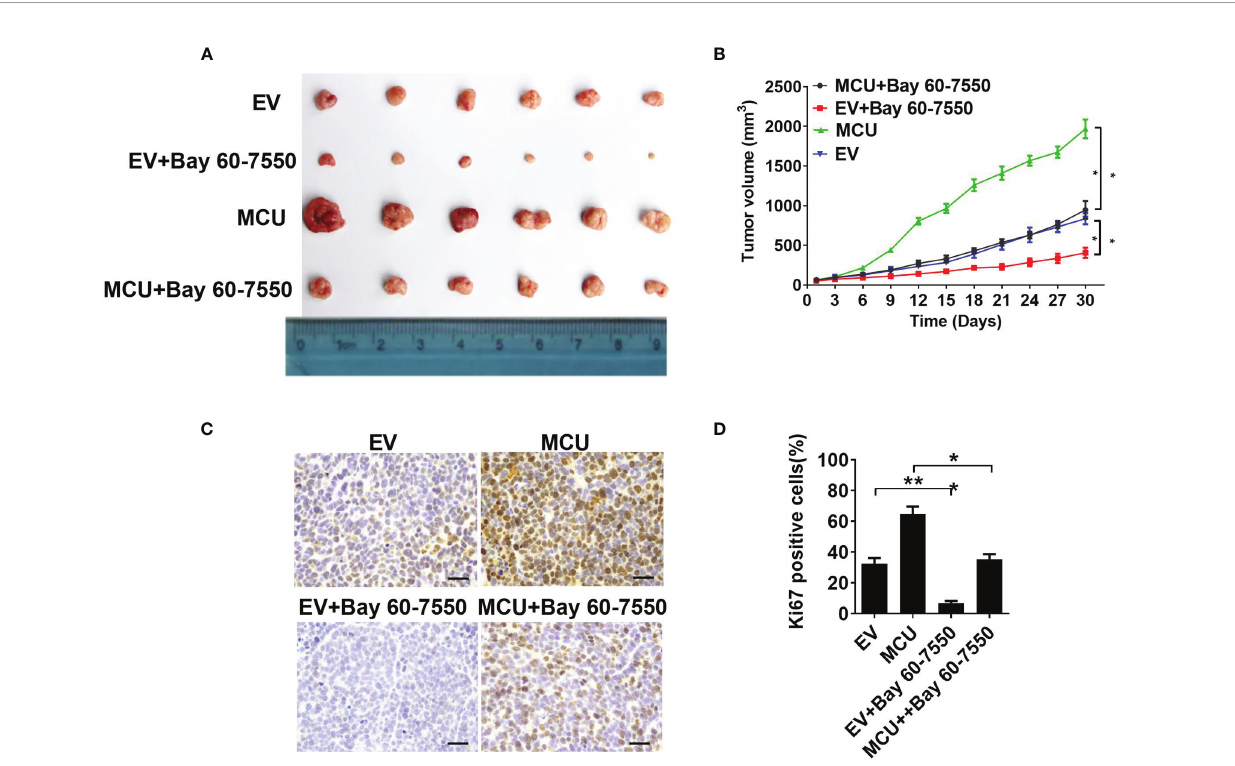
FIGURE 4 | Activation of PDE2 is essential for mitochondrial Ca2+-mediated CRC cell proliferation in vivo . (A) Dissected tumors from sacri fi ced mice and (B) tumor growth curves of subcutaneous xenograft tumor developed from LS174T cells with treatments as indicated. (C) Representative IHC staining images of Ki67 and (D) percentage of Ki67-positive cells in xenograft tumor developed from LS174T cells with treatments as indicated (scale bar, 50 m m). *P < 0.05; **P <